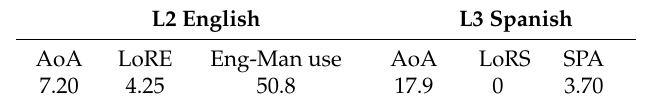
Table 2. Summary of L1 Mandarin–L2 English–L3 Spanish speaker participant